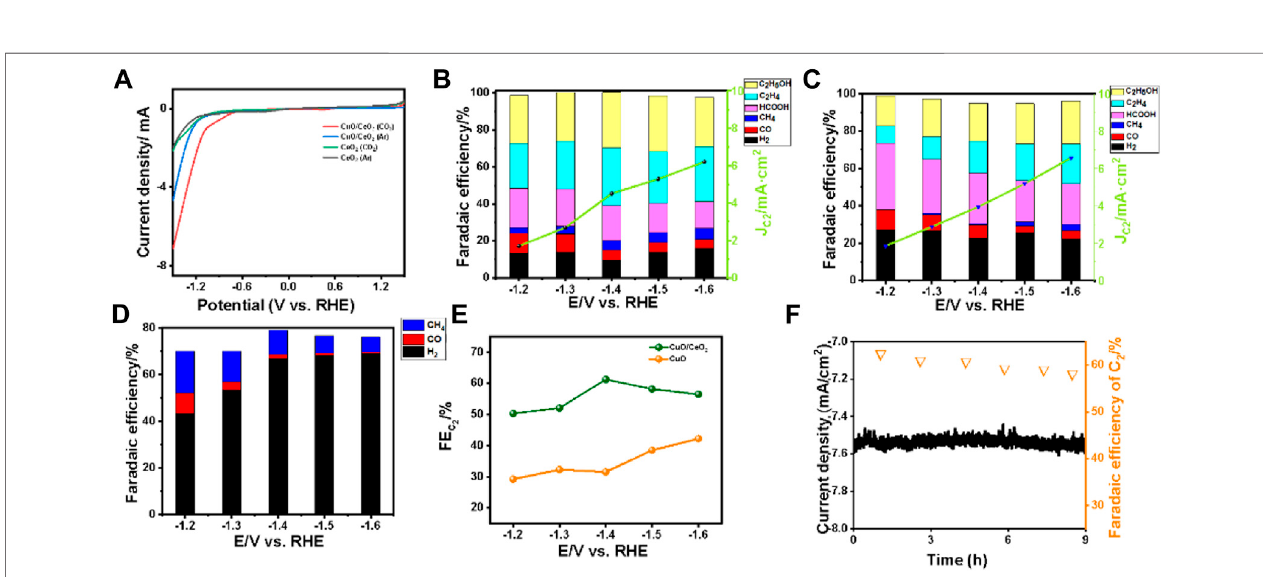
FIGURE 4 | (A) LSV curves of CeO 2 and CuO/CeO 2 under Ar- and CO 2 -saturated 0.1 M KHCO 3 in a single cell; density of CuO/CeO 2 ; (C) Faradaic ef fi ciency and C 2 products current density of CuO; (D) Faradaic ef fi ciency of CeO 2 ; (E) Comparison of Faraday ef fi ciency of CuO/ CeO 2 and CuO at different voltages; (F) stability curve and Faradaic ef fi ciency of C 2 during 9